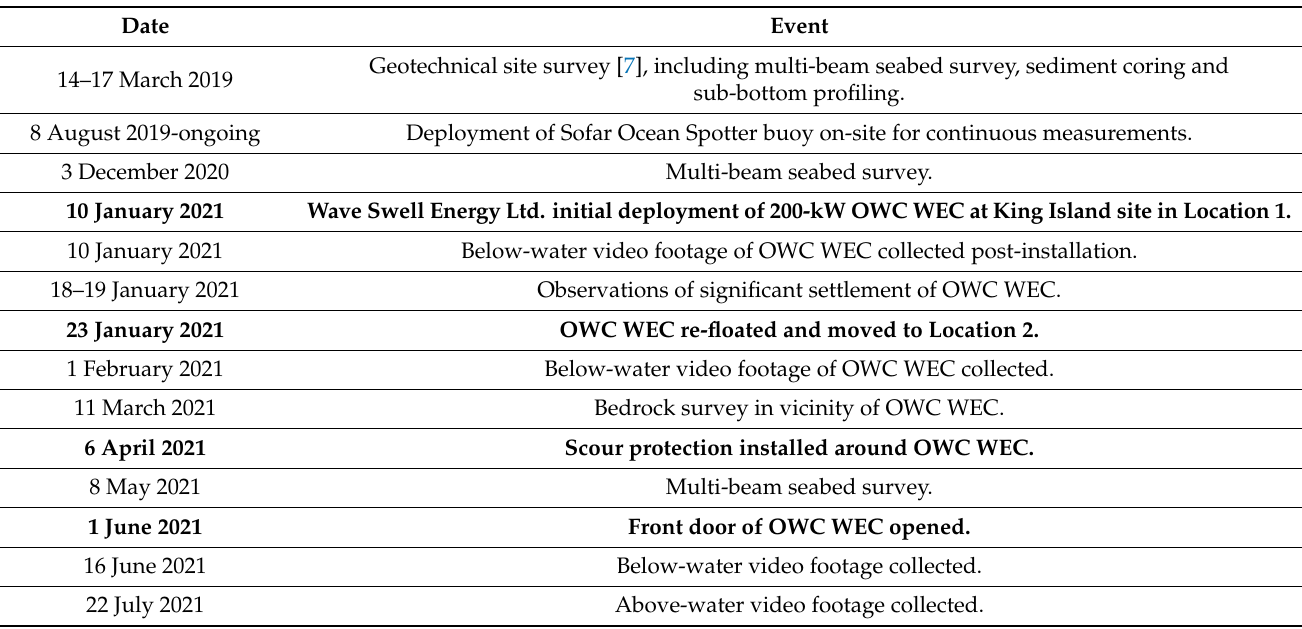
Table 2. Timeline of key events and date collection activities. Key changes to the OWC WEC deployment are highlighted in